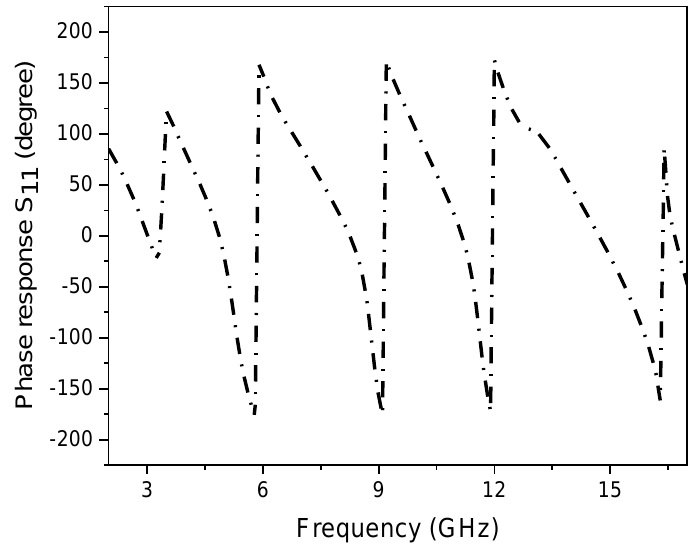
Figure 20. Group delay response of the proposed notched filter.